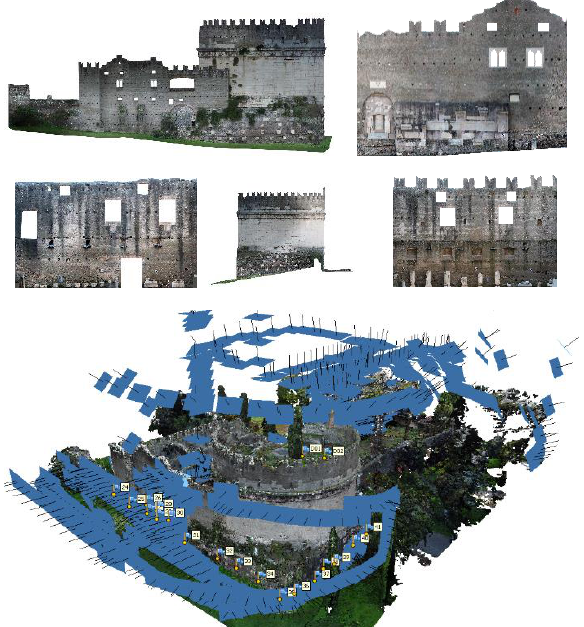
Figure 7. Aerial photogrammetric outputs (orthophotos and point